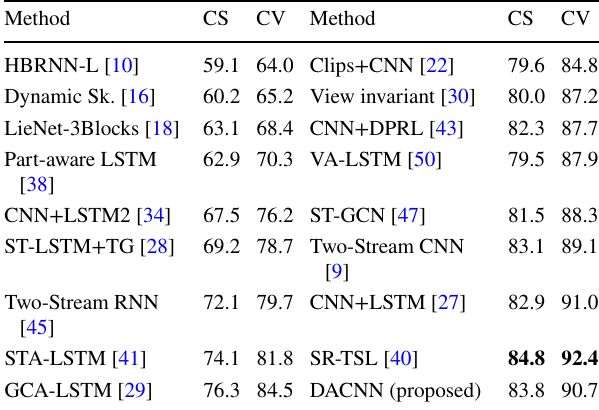
Table 3 Recognition accuracy (%) for NTU dataset regarding cross- view (CV) and cross-subject